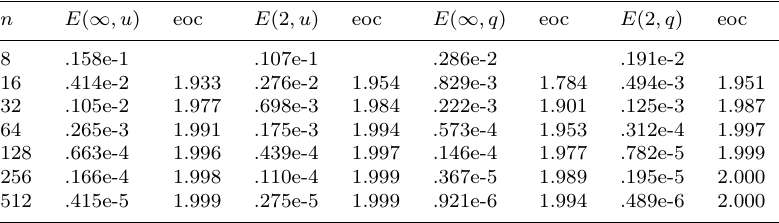
Table 2. Errors and orders of convergence of the P 0 − collocation on the polygonal boundary n